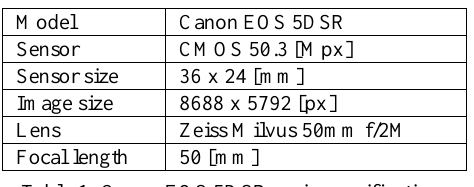
Table 1. Canon EOS 5DSR main specifications